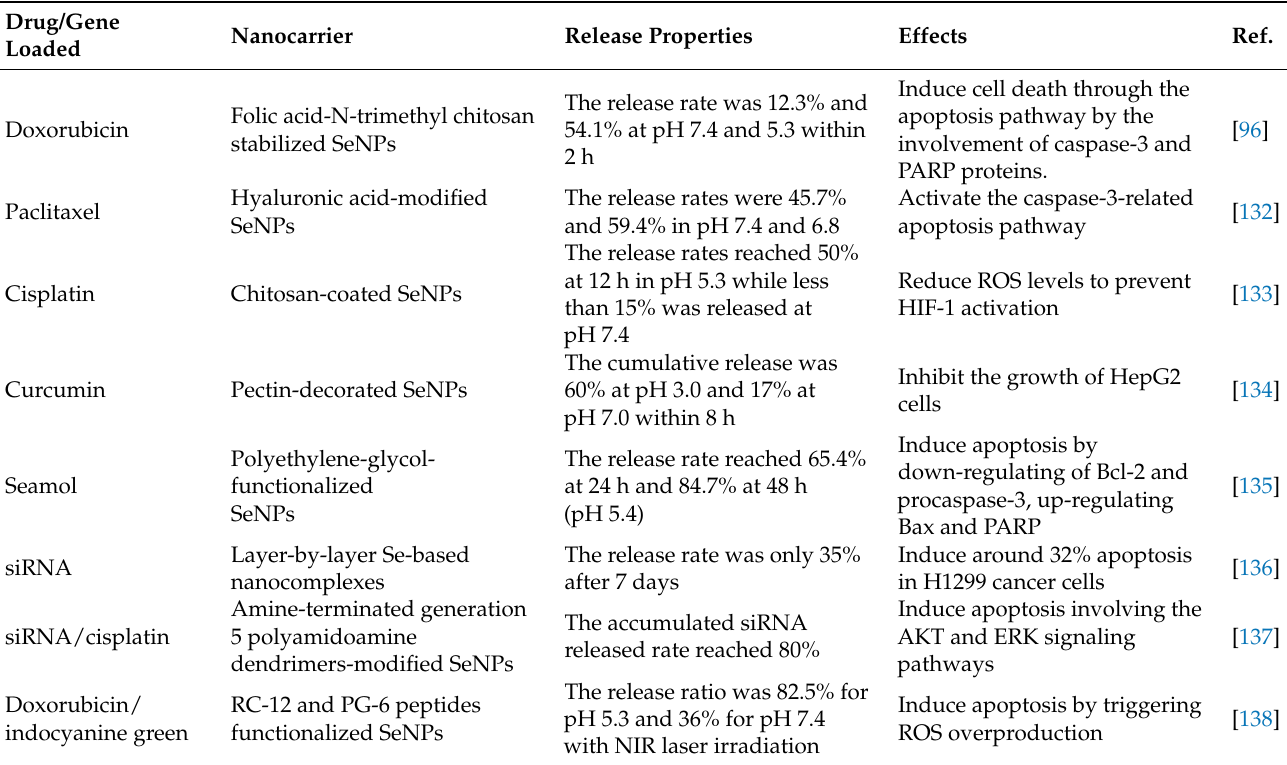
Table 3. Functionalized SeNPs as nanocarriers for drug/gene